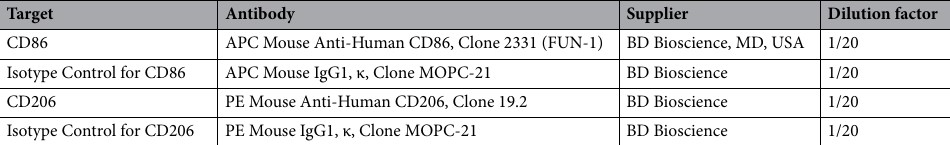
Table 1. Antibodies for flow